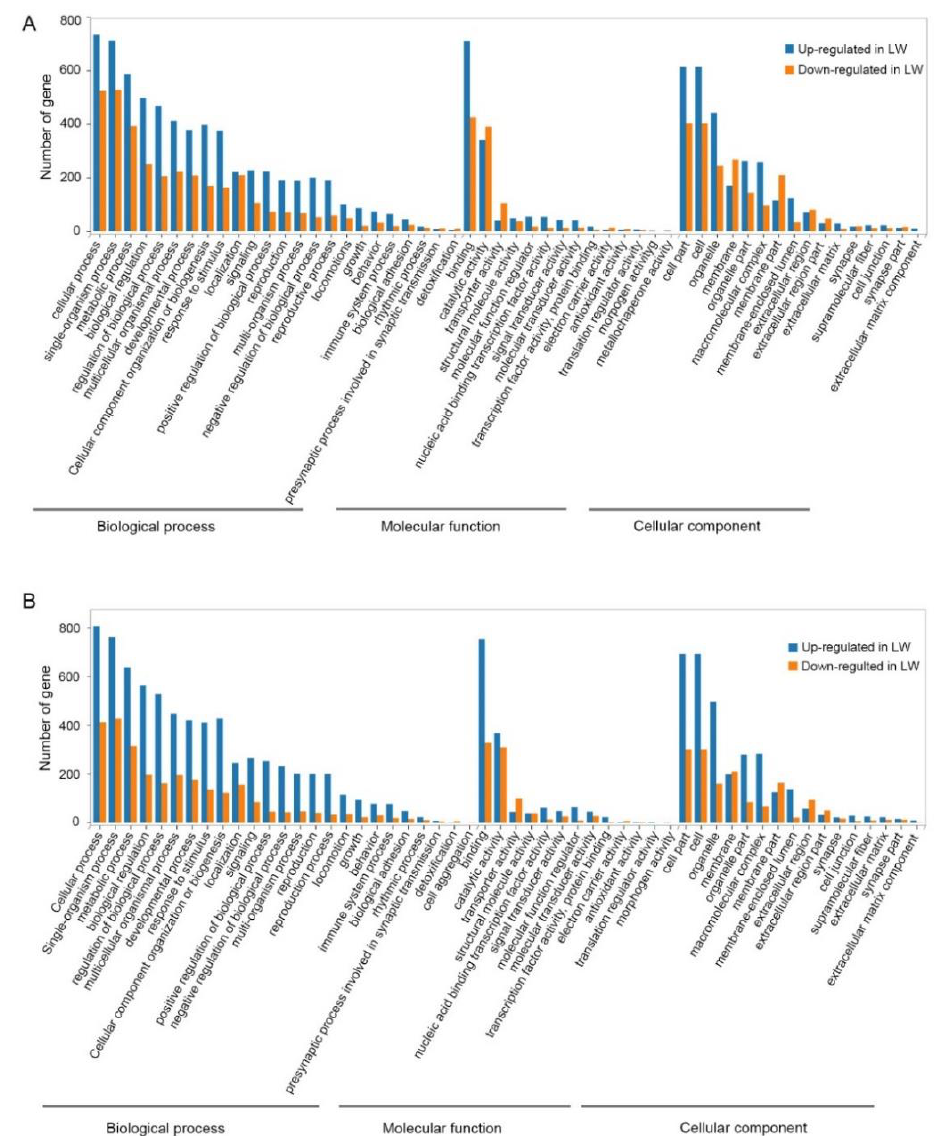
Figure 5. GO classification of DEGs in forewing ( A ) and hindwing ( B ) buds of 36 hAE-5th-instar nymphs with NlFoxO and Gfp knockdown. GO is summarized as three main categories (CC, MF and BP).